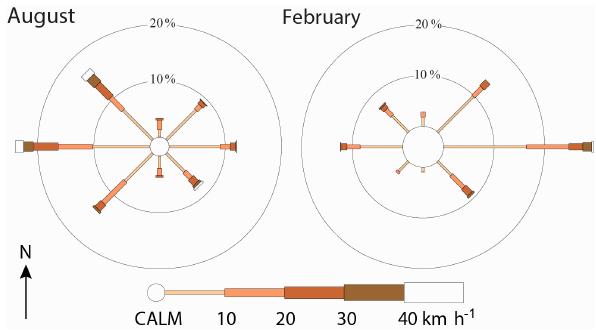
Figure 4. Rose of 09:00 wind direction vs. wind speed in kmh − 1 at Guyra Hospital, 1332ma.m.s.l. (Bureau of Meterology, 2014). Only winds above ∼ 22kph are sand-carrying (based on the 12-knot threshold of Fryberger, 1979). Sand drift potential is much stronger in winter (August) than it is in summer (February) because the re- lationship is a power function of the wind speed and frequency of very strong winds is much lower in